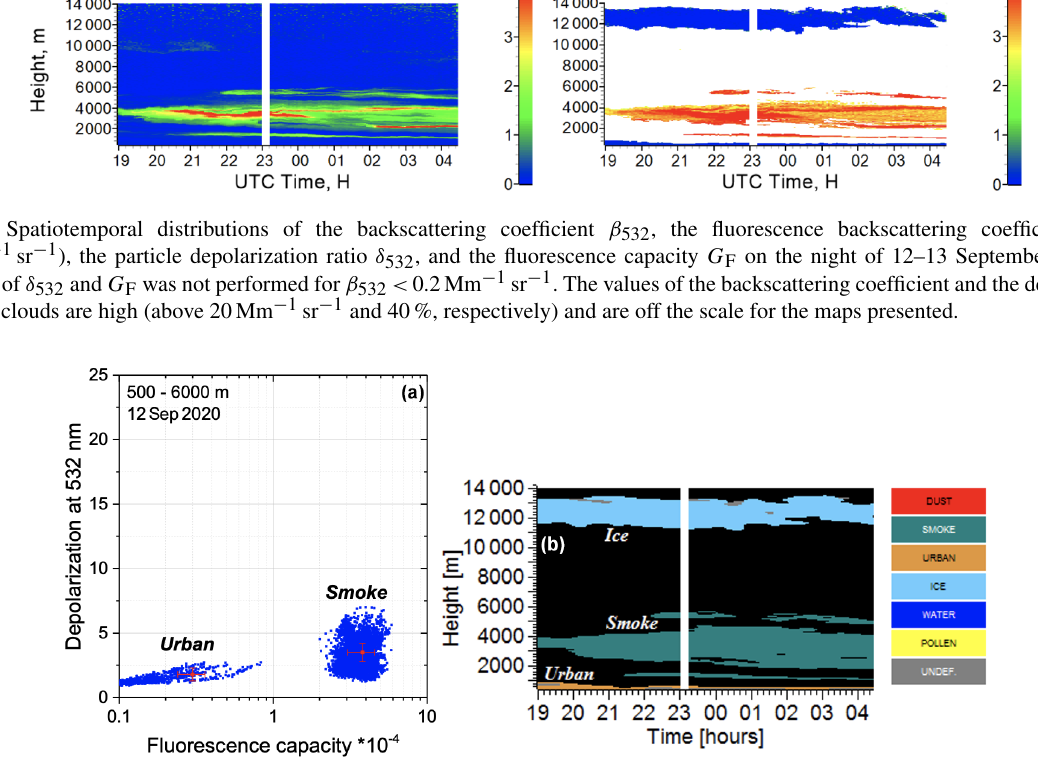
Figure 5. (a) The δ 532 - G F diagram for the data from Fig. 4 in the 500–6000m height range. Red crosses show the uncertainty of the measurements. (b) Spatiotemporal distribution of aerosol types on the night of 12–13 September 2020. The gray coloring shows undefined aerosol types, while measurements with β 532 < 0.2Mm − 1 sr − 1 are marked in